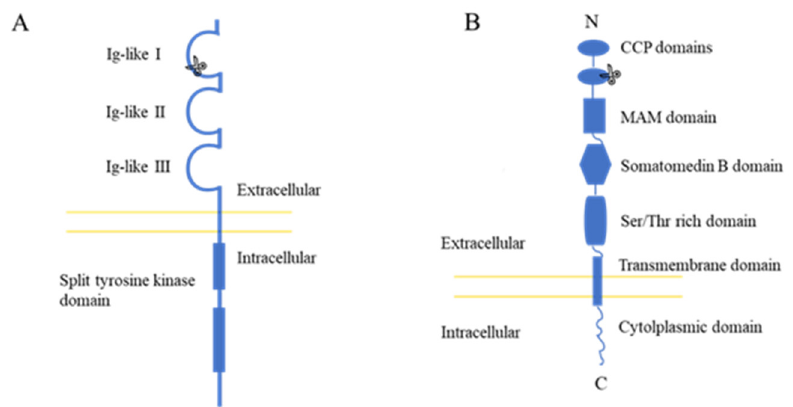
Figure 3. Basic structures of the FGFR ( A ) and SR-C ( B ). The figures were adapted from [34] and [35] respectively.